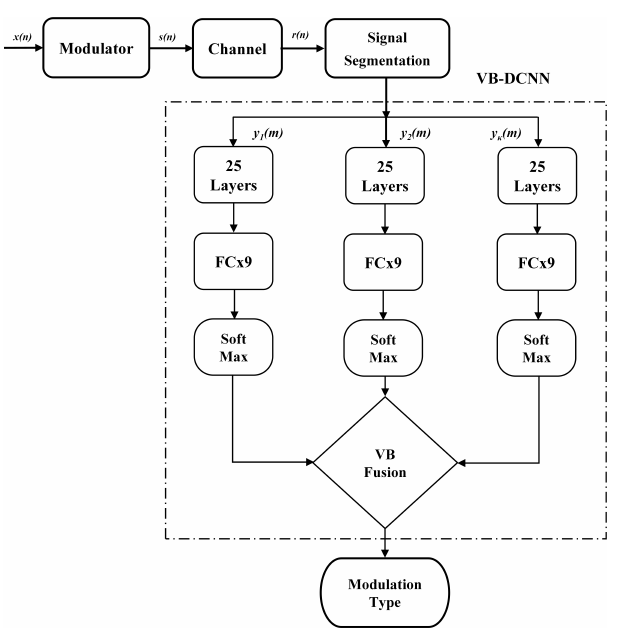
Figure 1. Proposed System Model for Voting-Based